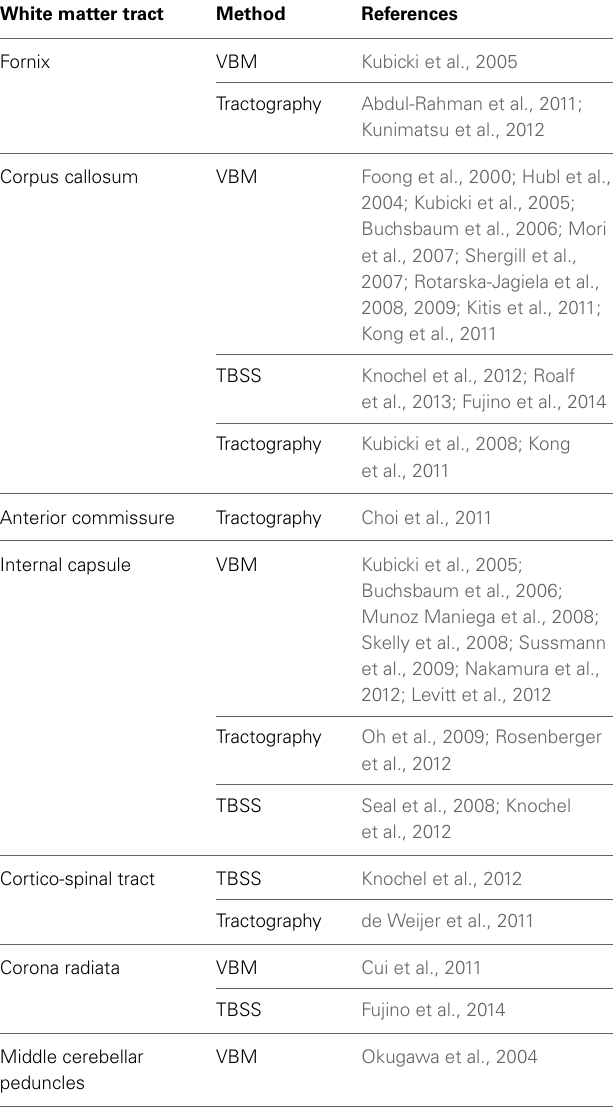
Table 1 | White matter tract alterations in patients with chronic